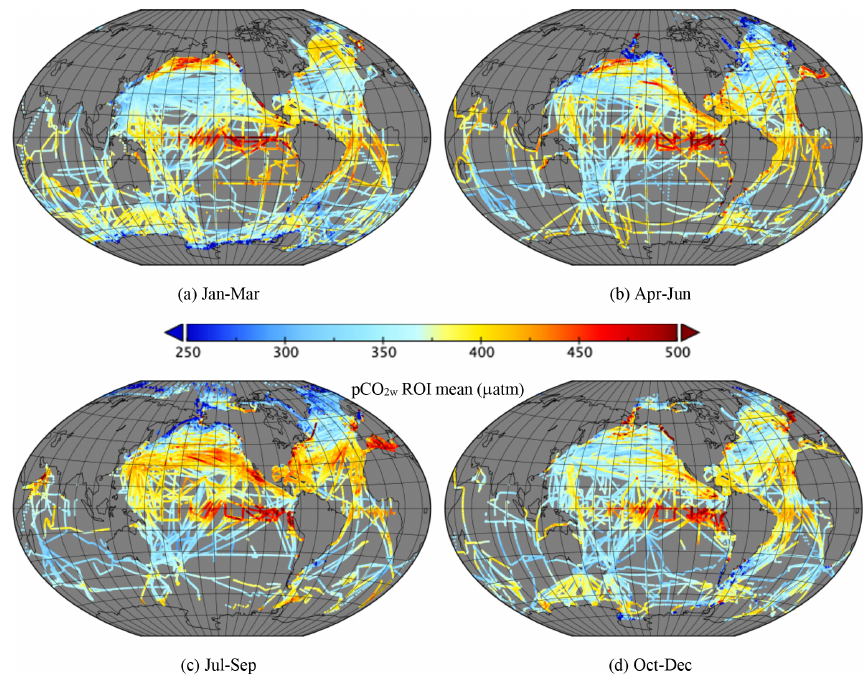
Figure 7. Mean pCO 2w (µatm) divided into seasons. (a) January–March (70658 ROIs), (b) April–June (67631 ROIs), (c) July–September (69083 ROIs) and (d) October–December (65381 ROIs).